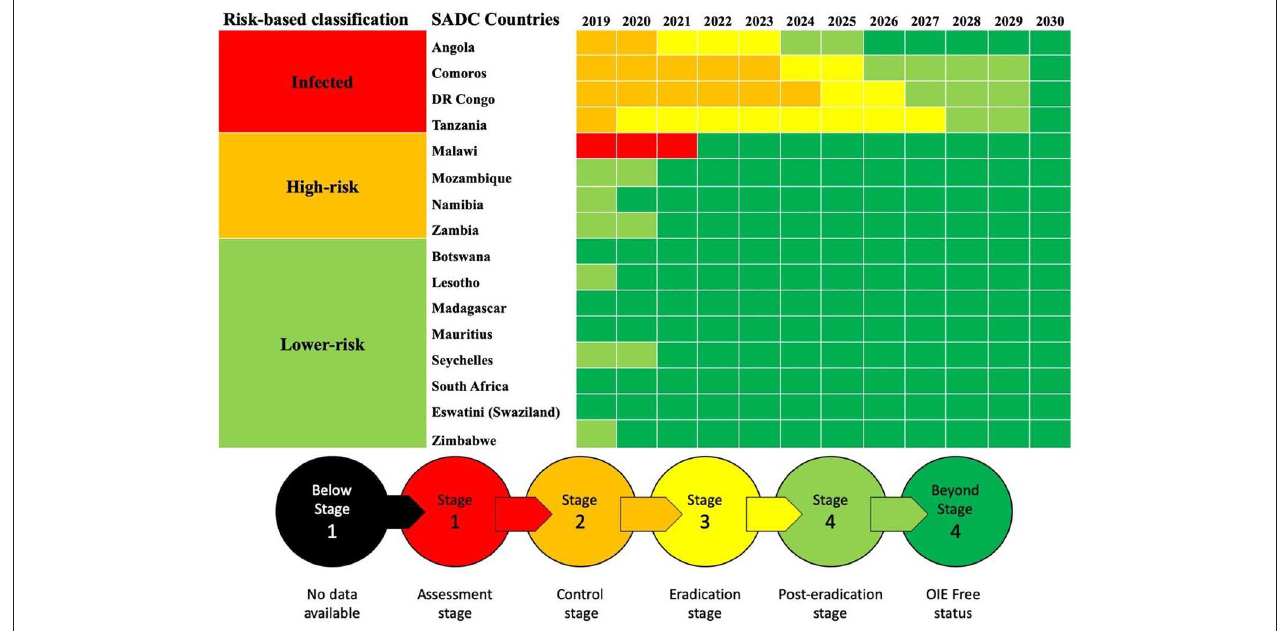
FIGURE 2 | Progressive control pathway for SADC countries as reported during and following the Second Road Map Meeting, March 2019, Lusaka,